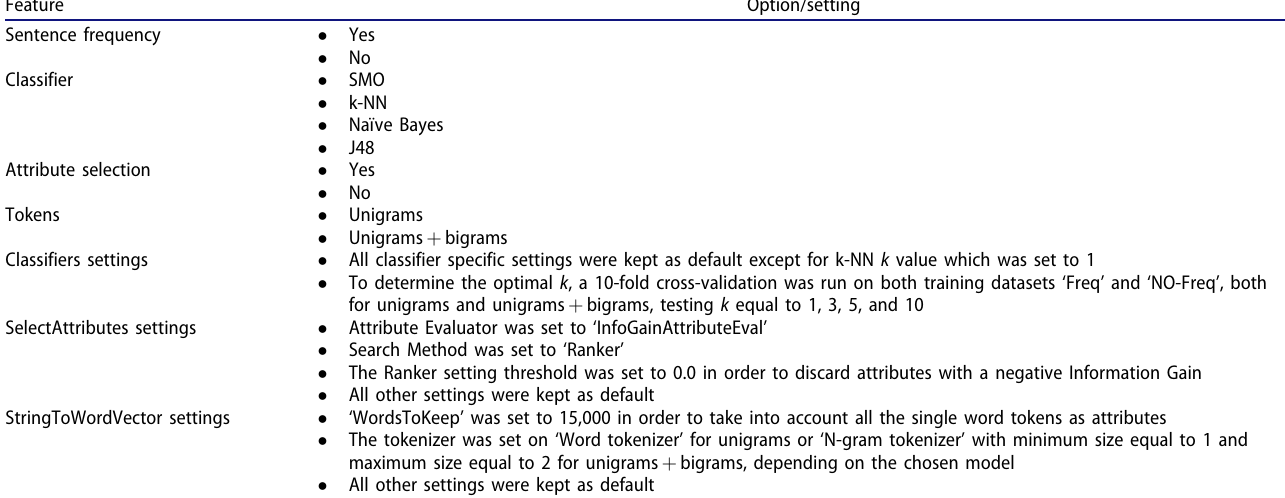
Table 1. Summary of features and weka settings used to create the models.